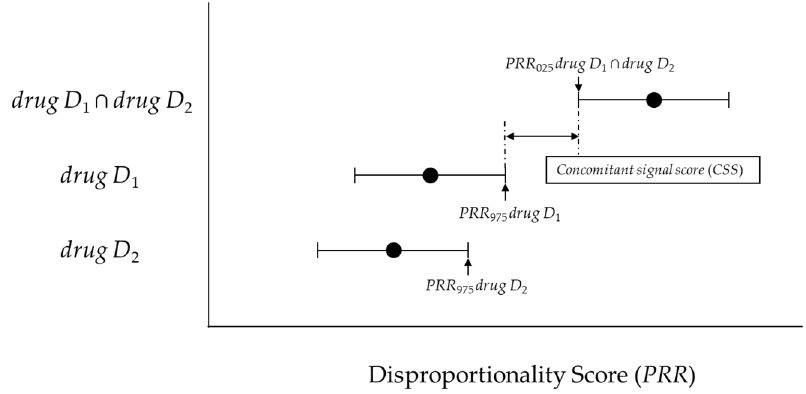
Figure 2. The association between the concomitant signal score ( CSS ) and disproportionality score.